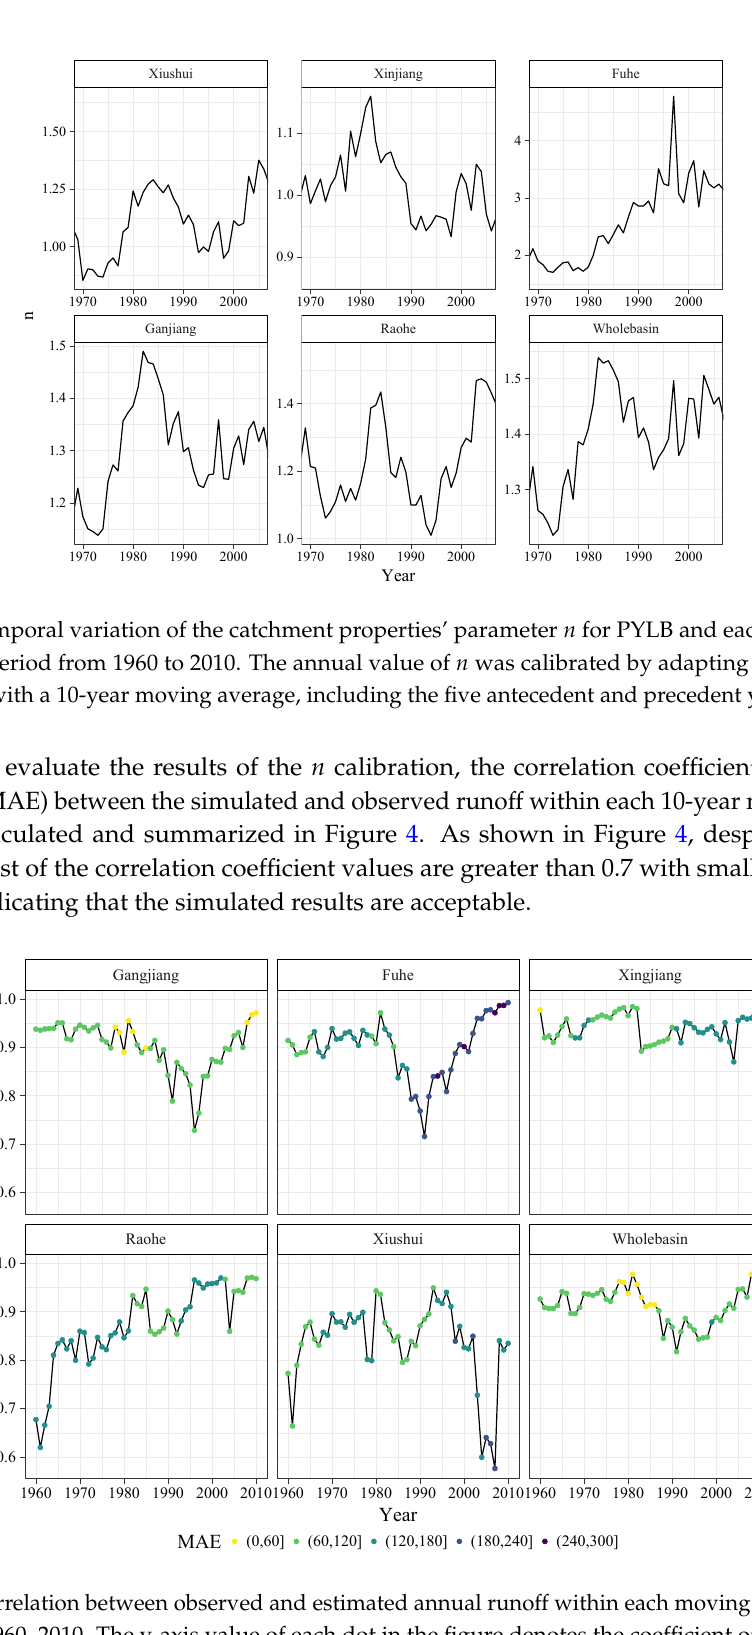
Figure 4. Correlation between observed and estimated annual runoff within each moving window for the period 1960–2010. The y-axis value of each dot in the figure denotes the coefficient of correlation between the simulated and observed runoff in a 10-year moving window, and the shade of the dot represents the mean absolute error (MAE) between the observed and the simulated annual runoff in each 10-year moving